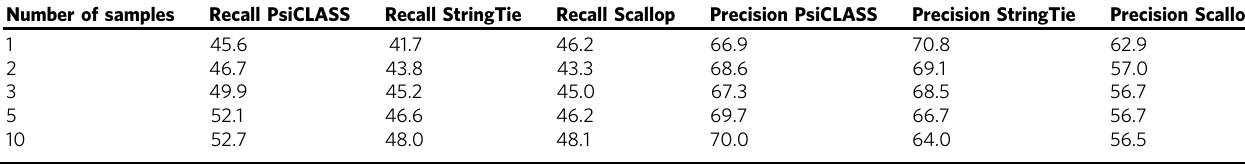
Table 1 Performance of methods on experiments with small numbers of samples on simulated data Number of samples Recall PsiCLASS